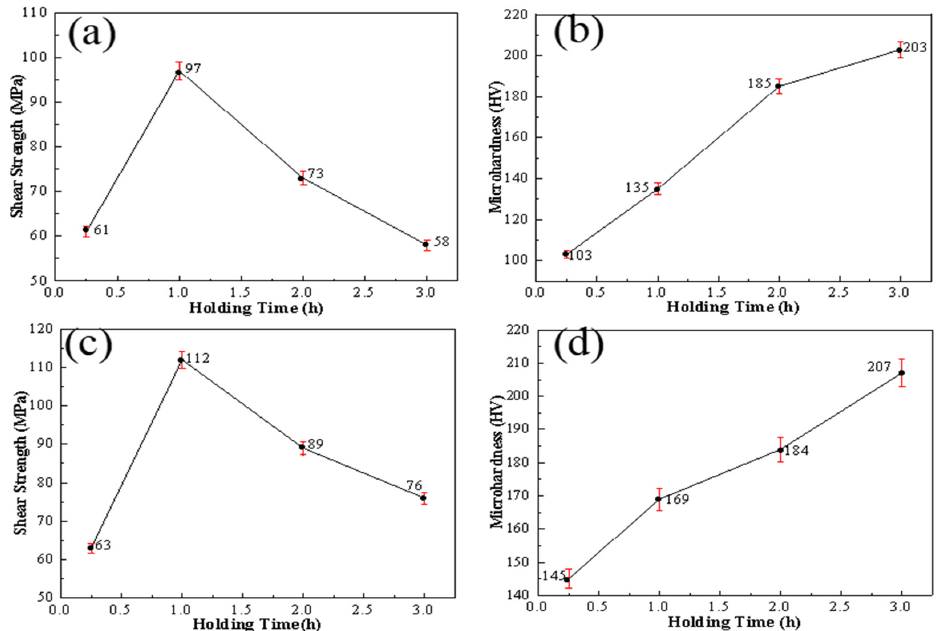
Figure 14. Mechanical properties and microhardness of joints under different holding times: ( a , b ) Ti/Cu/Ti shear strength and interlayer microhardness; ( c , d ) Ti/Cu/Kovar/Cu/Ti shear strength and interlayer microhardness.